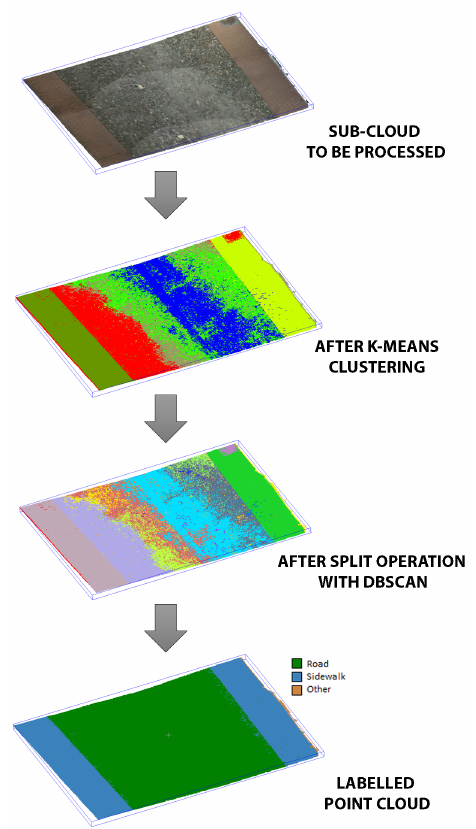
Figure 3. The process of sidewalk segmentation and